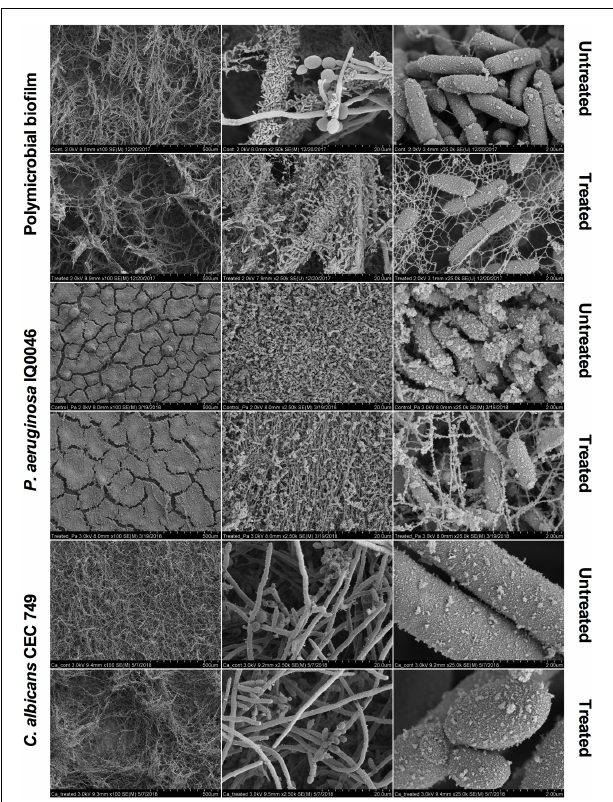
FIGURE 3 | Scanning electron microscope images showing the bactericidal activity of aBL at 405 nm in P. aeruginosa IQ0046 and MRSA USA300 monomicrobial and dual-species microbial biofilms after an aBL exposure of 500 J/cm 2 (92.6 mW/cm 2 and 90 min). Scale bars represent 20 or 2 µ m.